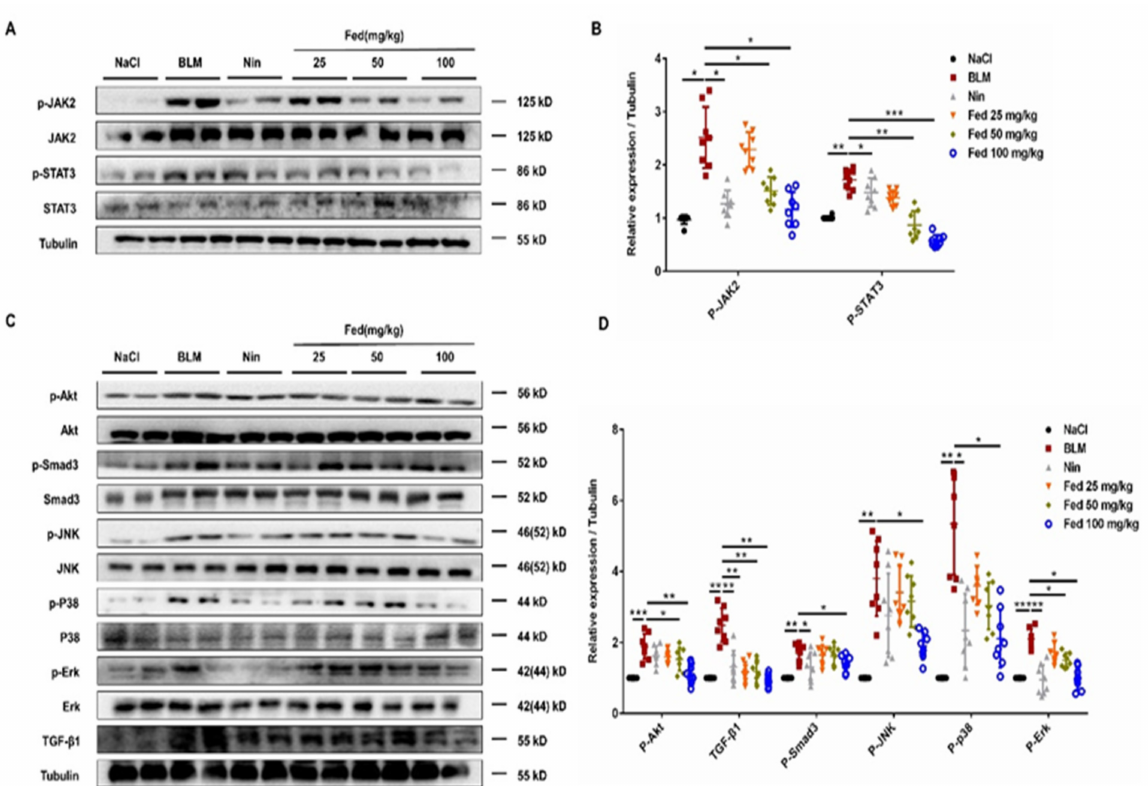
Figure 9. Fedratinib alleviates myofibroblast activation in bleomycin-induced mice by inhibiting both JAK2/STAT3 and TGF- β 1 signaling. ( A ) Western blot analysis of the protein levels of JAK2 and STAT3 in lung tissues. ( B ) Densitometric analysis of P-JAK2 and P-STAT3 in the immunoblots, using tubulin as the internal reference. ( C , D ) Western blot analysis of the protein levels of Smad3, P38, JNK, Erk, Akt and TGF- β 1 in lung tissues. Data are presented as the means ± SD ( n = 8). Comparisons between groups were achieved using one-way analysis of variance (ANOVA). * p < 0.05, ** p < 0.01, *** p <